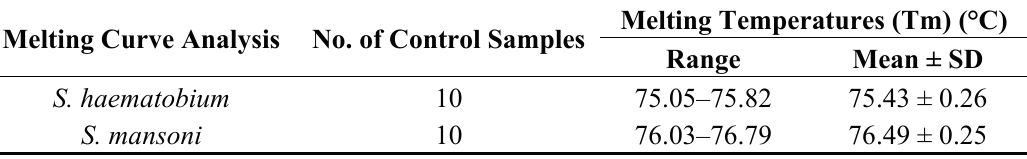
Table 1. Melting temperature values of real-time